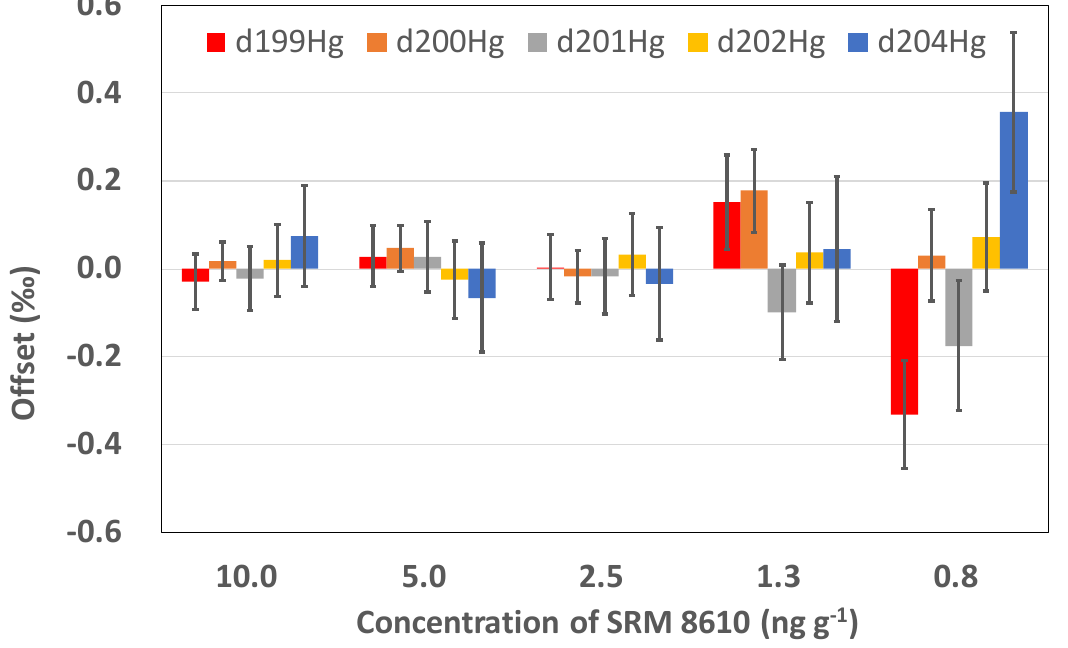
Figure 2. Dependence of the accuracy of stable mercury isotope measurements of SRM 8610 on the concentration. “Offset” indicates the difference between the measured and reference isotope ratios (offset = measured-reference). Error bars refer to the propagated errors estimated from the uncertainty given for SRM 8610 by NIST and the standard errors from the 50 replicate measurements.